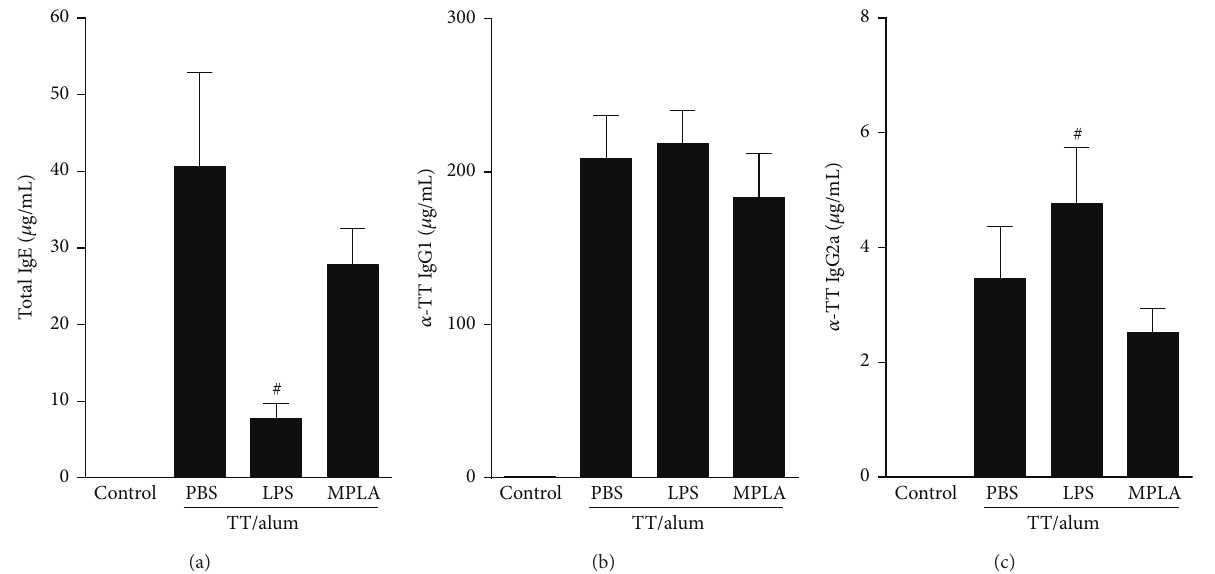
Figure 3: Effects of adsorption of LPS or MPLA onto TT/alum sensitization on serum isotype production. Protocol as shown in Figure 2(a). Concentration of serum isotypes: (a) total IgE, (b) TT-specific IgG1, and (c) TT-specific IgG2a. Data shown as mean ± SE, one-way ANOVA: # 𝑃 < 0.05 ; different from TT/alum/PBS group ( 𝑛 = 5 ), and experiment was repeated